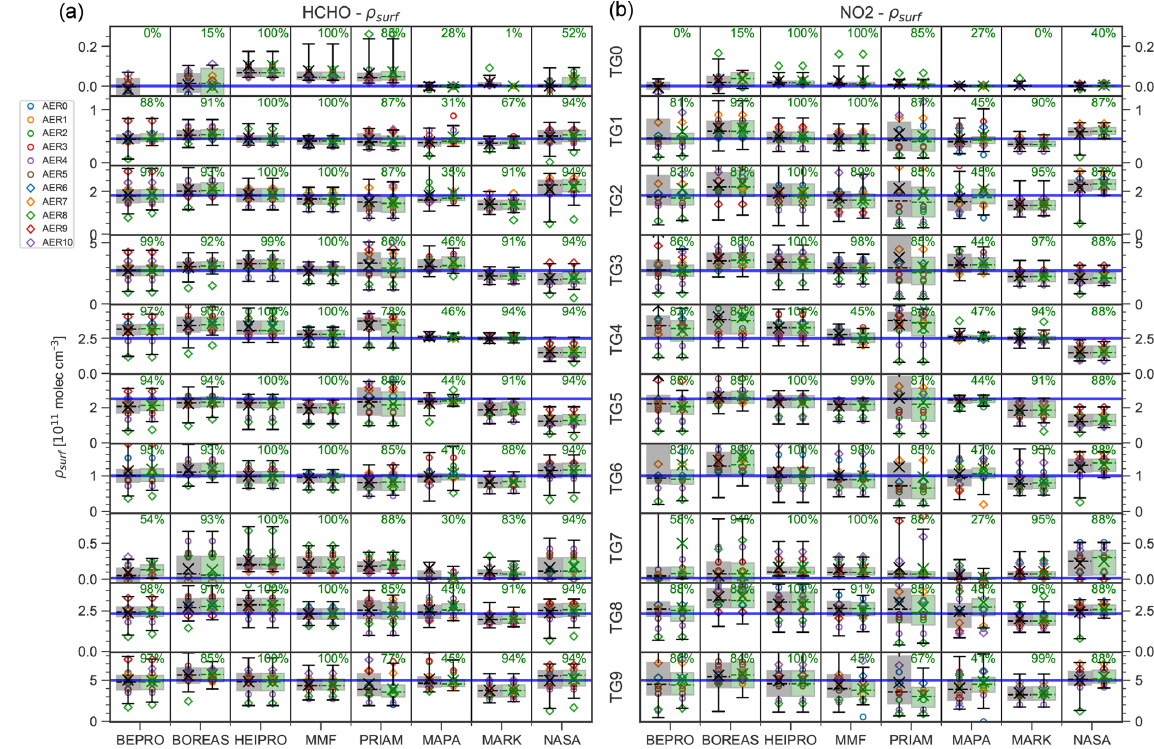
Figure 20. Same as Fig. 19, but for HCHO (a) and NO 2 (b) surface concentrations. The median for each aerosol scenario is shown as coloured symbol as indicated in the legend.